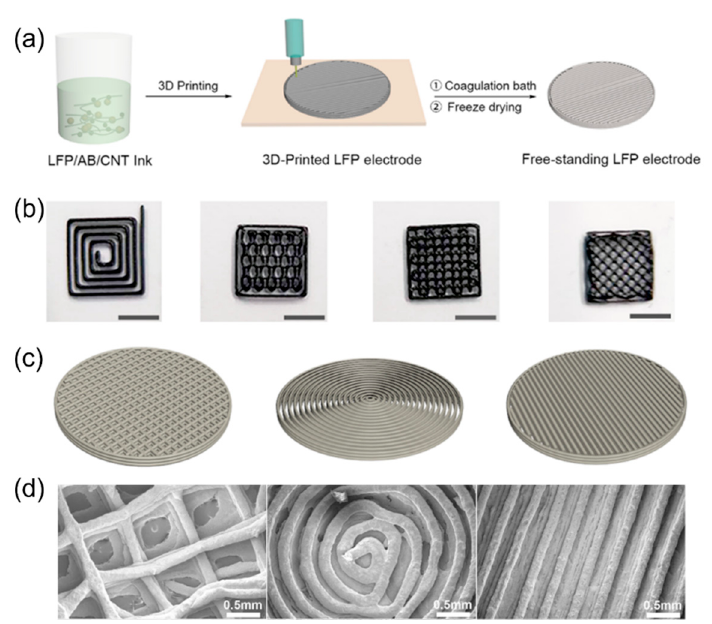
Figure 10. ( a ) Fabrication procedures of 3D-printed LFP electrodes. ( b ) Images of 3D-printed LFP electrodes with various patterns (scale bars: 7 mm). ( c ) Three types of patterns for 3D-printed electrodes. ( d ) Microstructure images of 3D-printed electrodes with grid, ring, and line structures. Reproduced with permission from ref. [113]. Copyright 2018, ACS Publications.